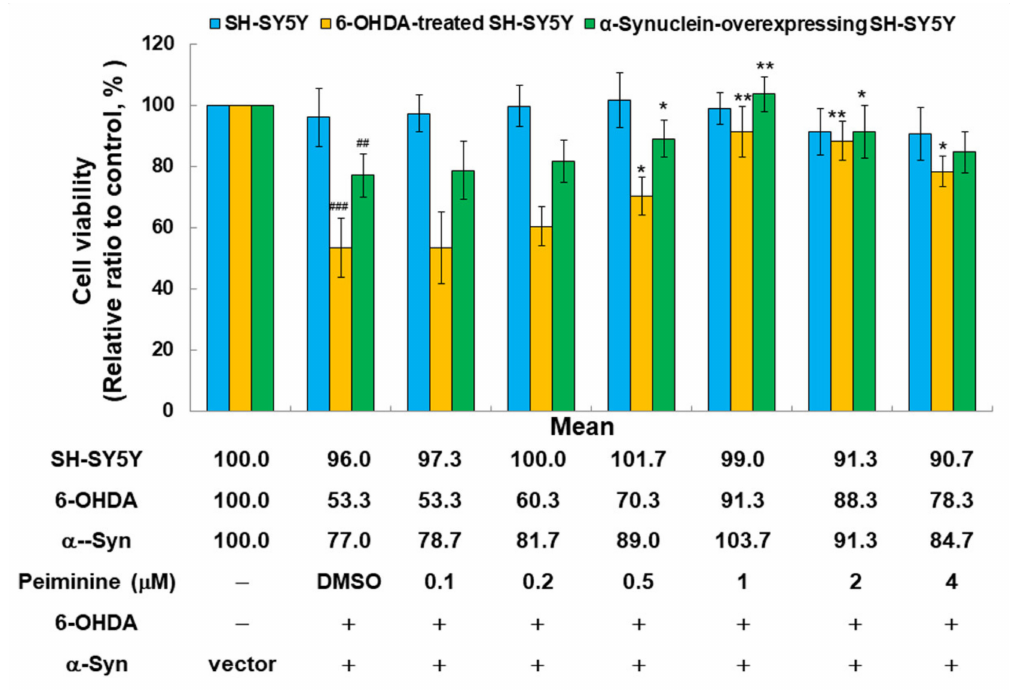
Figure 8. PMN treatment reduces the toxicity of 6-OHDA exposure and α -synuclein overexpression in the SH-SY5Y cell line. Cells were treated with 0.1, 0.2, 0.5, 1, 2, or 4 µ M PMN for 24 h (SH-SY5Y group), followed by 6-OHDA exposure for 18 h (6-OHDA-treated SH-SY5Y group), or α -synuclein-overexpressing cells were treated with PMN for 24 h ( α -synuclein- overexpressing SH-SY5Y group), and the cell survival rate was determined by MTT assay. # Indicates a significant difference between the 6-OHDA-exposed group or α –synuclein-overexpressing group and the control group ( ## p < 0.01, ### p < 0.001). * Indicates a significant difference between the PMN-treated group and the PMN-untreated group (* p < 0.05, ** p <